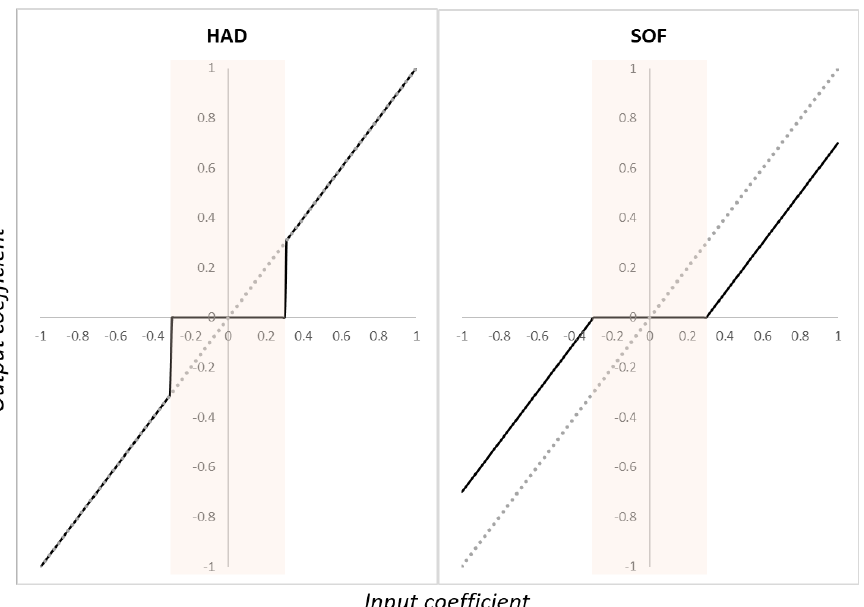
Figure 11. Output coefficient obtained according to the input coefficient for HAD ( left ) and SOF ( right )